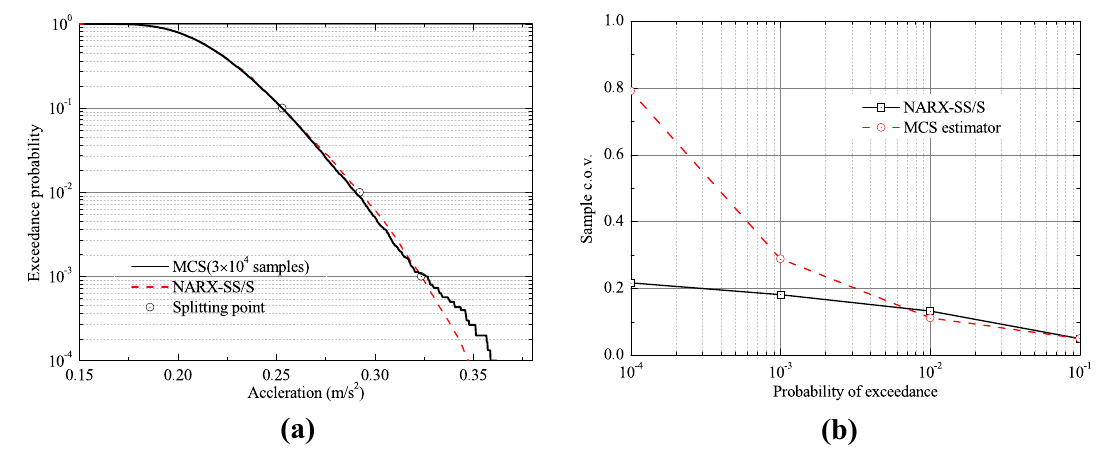
Fig. 8 Comparison of MCS and NARX-SS/S methods: a exceedance probability of the train body acceleration and b comparison of the c.o.v. for different estimators